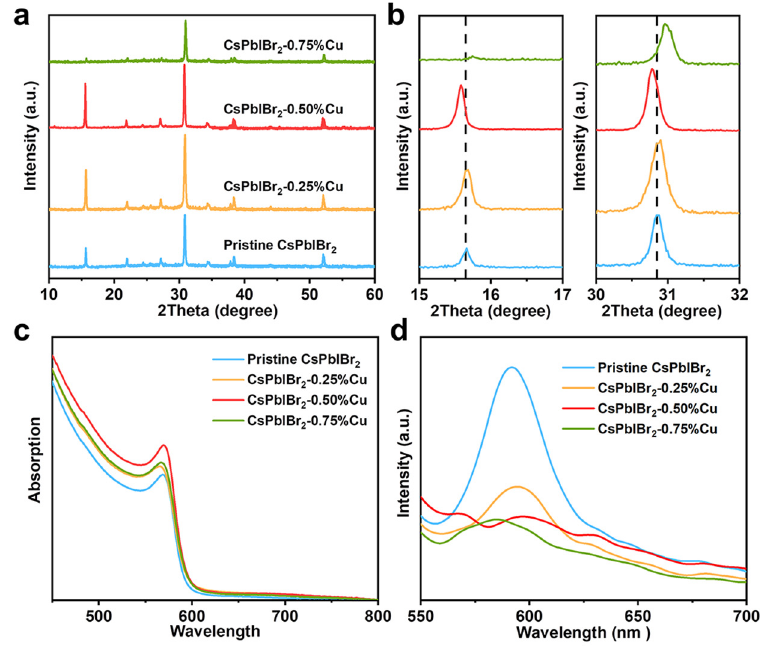
Figure 2. ( a ) XRD patterns, ( b ) magnified (100) and (200) peaks, ( c ) UV-vis and ( d ) PL spectra (de- posited on conductive substrate ) of CsPbIBr 2 and different Cu + -doped CsPbIBr 2